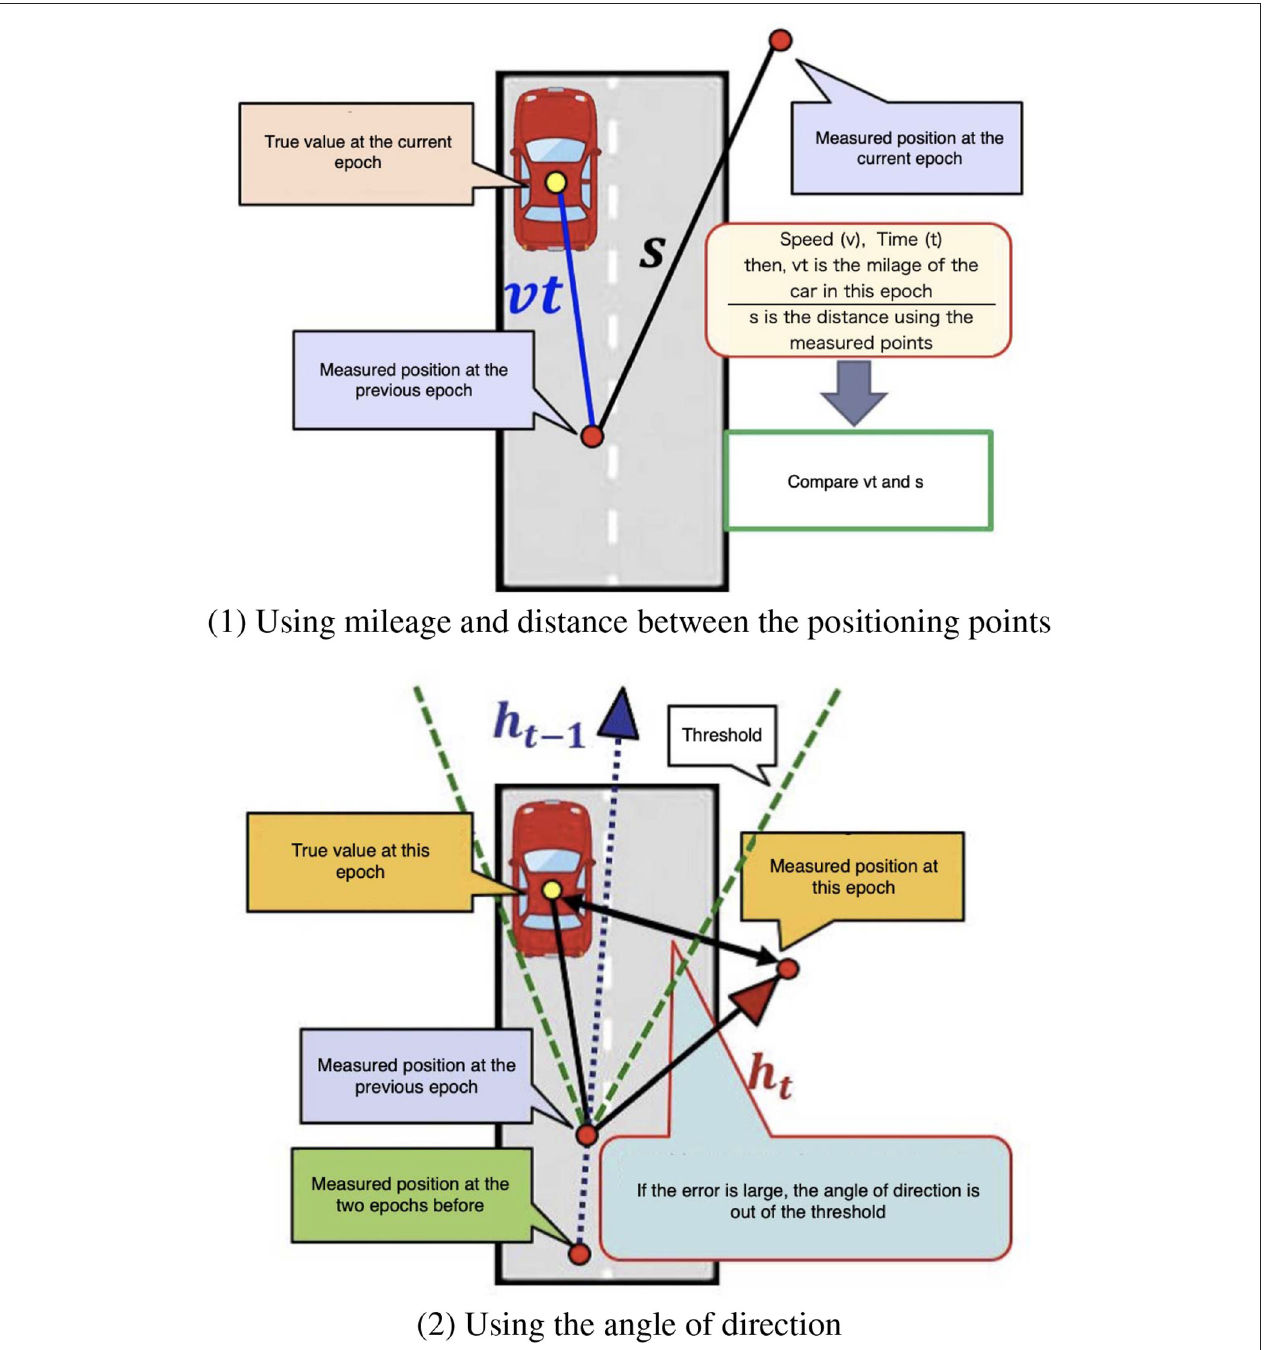
FIGURE 7 | Error level estimation